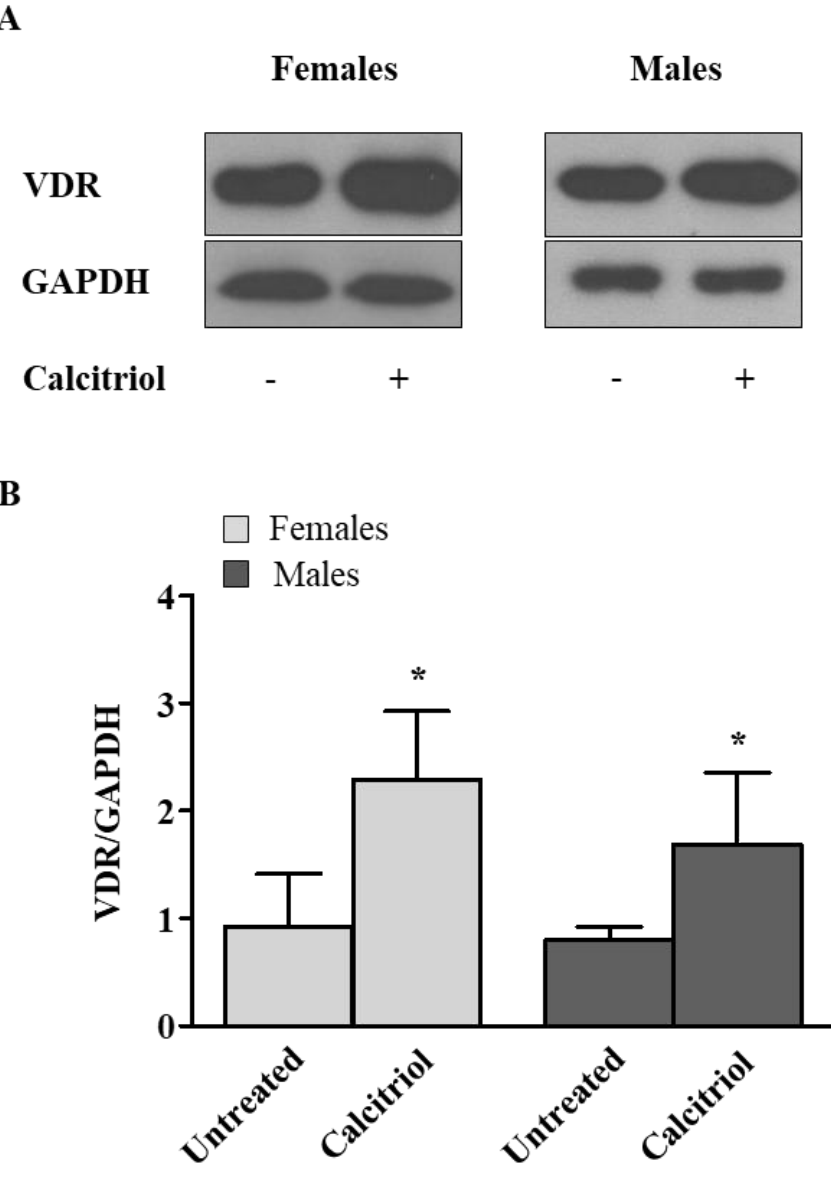
Figure 1. Calcitriol upregulates VDR expression in activated peripheral blood T lymphocytes from female and male healthy donors. VDR levels were evaluated by Western blot analysis of T cell lysates after 48 h of calcitriol treatment. ( A ) Blots shown are representative of experiments performed in T cells from 10 randomly selected female and male healthy subjects. ( B ) Densitometry analysis of VDR levels relative to glyceraldehyde 3 − phosphate dehydrogenase (GAPDH) is shown. Results are shown as mean ± SD. * p < 0.05 versus untreated cells. the IL-4 expression after the calcitriol treatment (data not